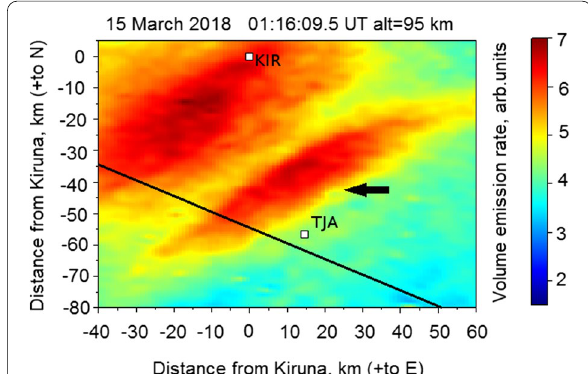
Fig. 2 Auroras in the common KRN–TJA field of view extracted from tomographic volume distribution of the 557.7 emission at an altitude of 95 km. The black arrow shows the structure under consideration, and the black line is the profile along which the altitude distribution of arc luminosity was calculated